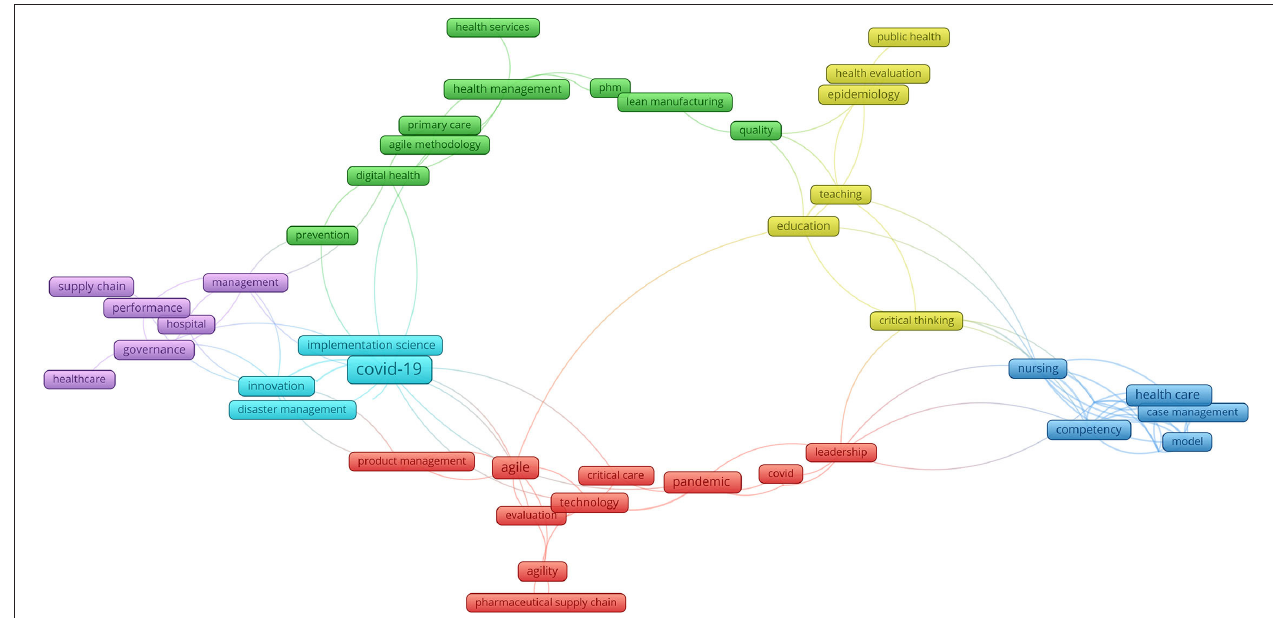
FIGURE 2 | Agile in digital